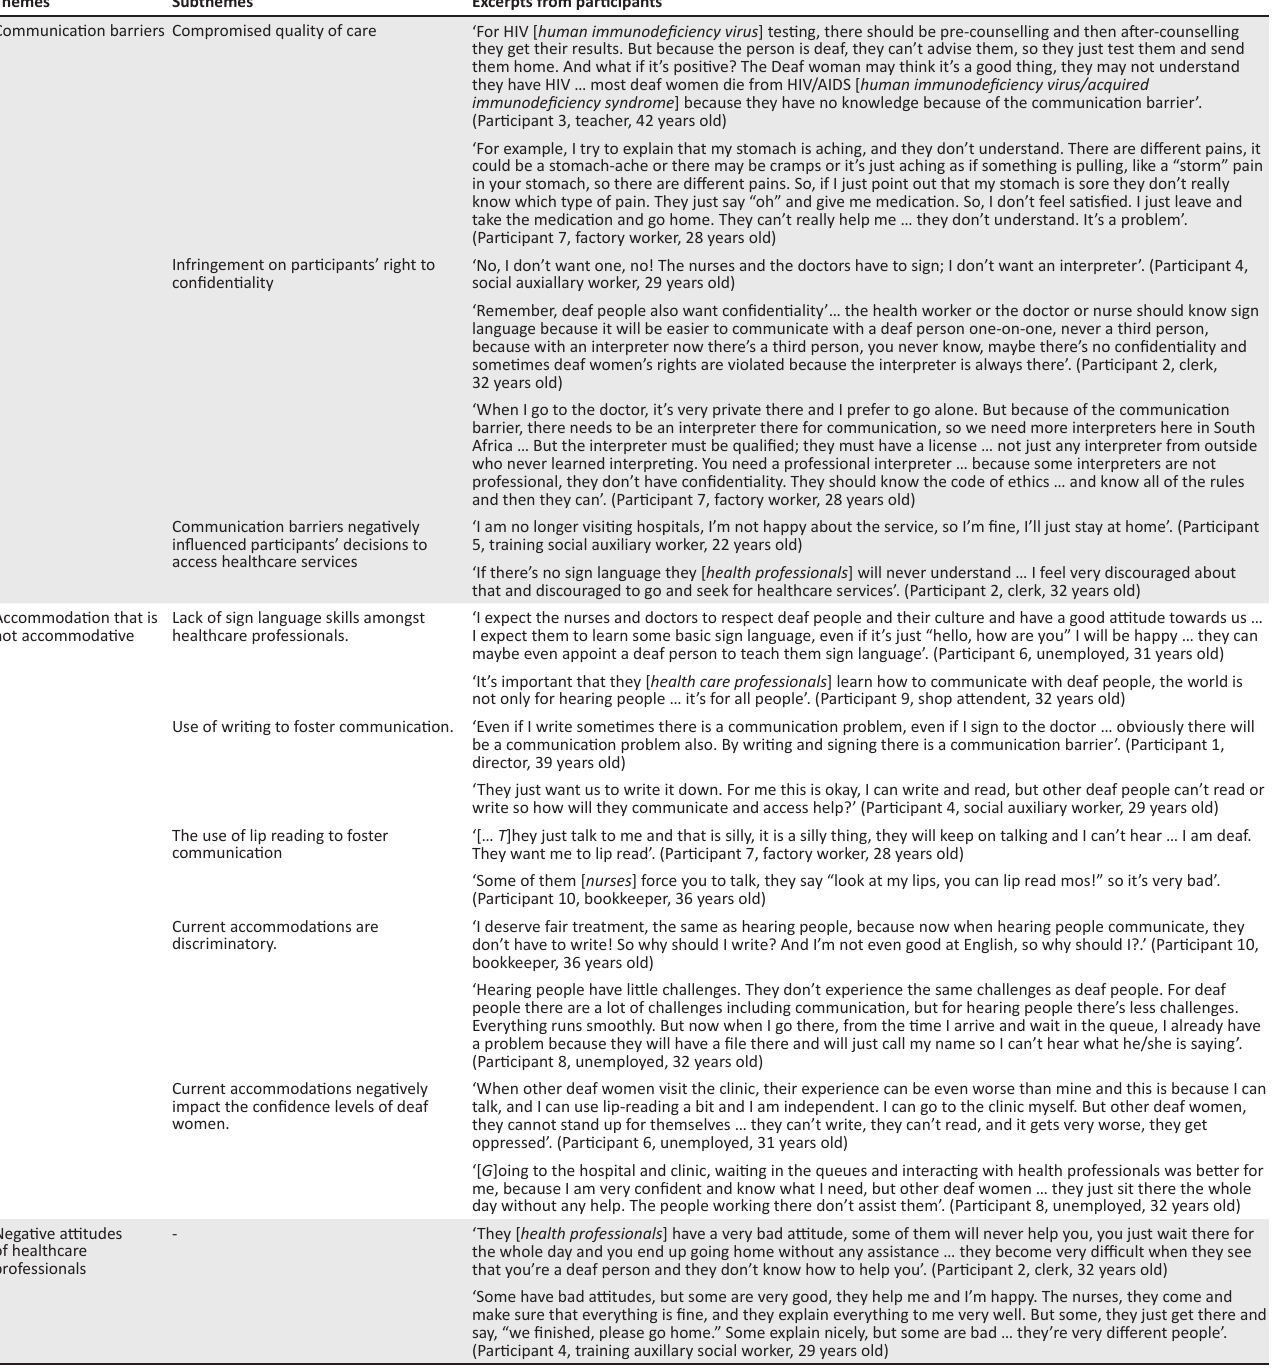
TABLE 2: Themes and subthemes from interviews with